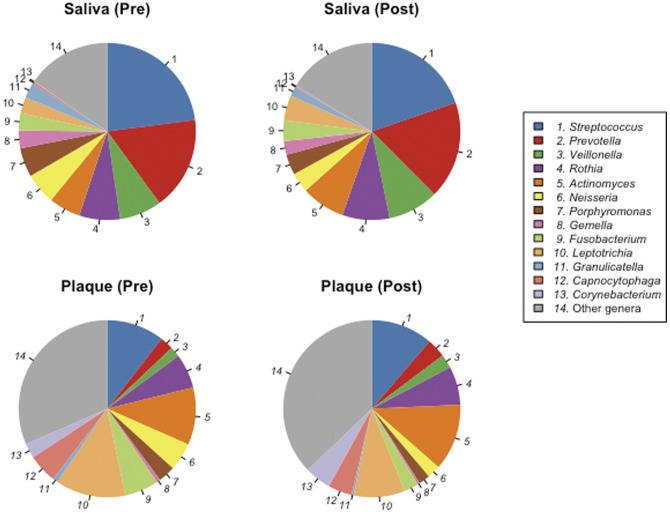
Mean genus abundances in the supragingival plaque microbiota and salivary bacterial population before and after periodontal therapy.Only 13 genera commonly detected in supragingival plaque or saliva samples are shown.